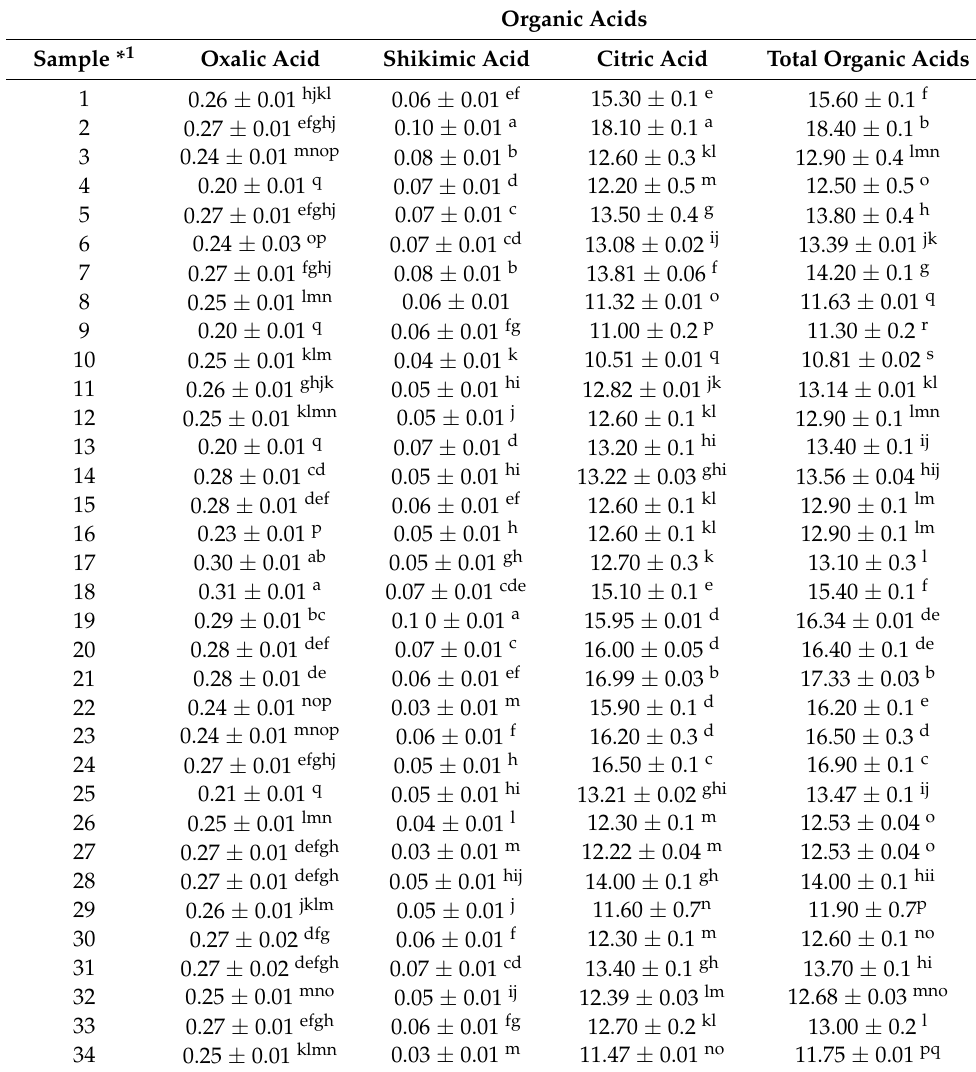
Table 3. Composition regarding organic acids (g/100 g fw) of the studied Pardina lentil “Lenteja de Tierra de Campos” (mean ± SD, n = 3). Organic